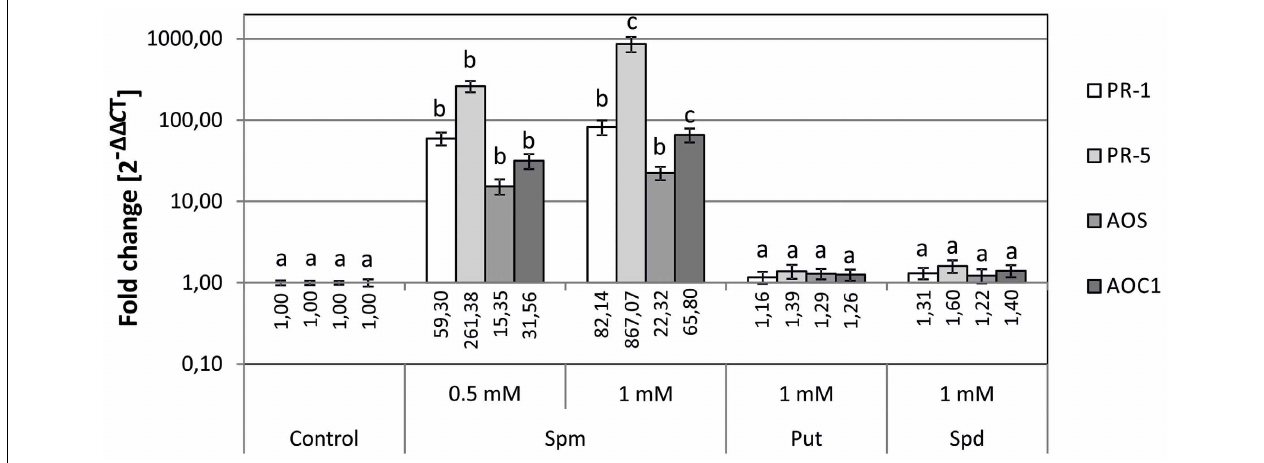
qRT-PCR. For each gene, data is expressed as fold change relative to the level measured in WT plants in control conditions (2 − (cid:2)(cid:2) CT ). Graph show the mean of three biological replicates ± standard deviation. Significant differences between treatments are indicated with letters (ANOVA, Tukey HSD test, p < 0 .